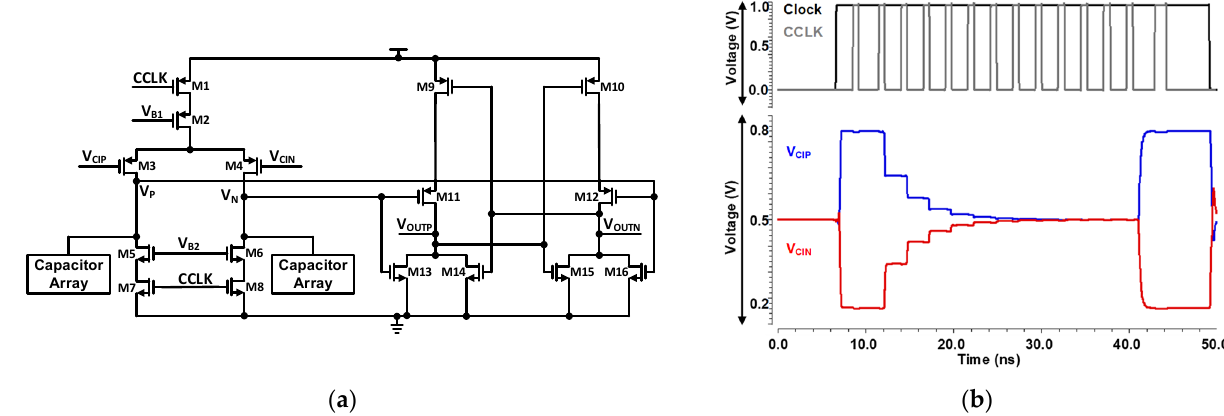
Figure 9. ( a ) Schematic of Dynamic Latched Comparator using Cascode to reduce kick-back (DNL), and ( b ) Waveform represented the CDAC settling with comparator.